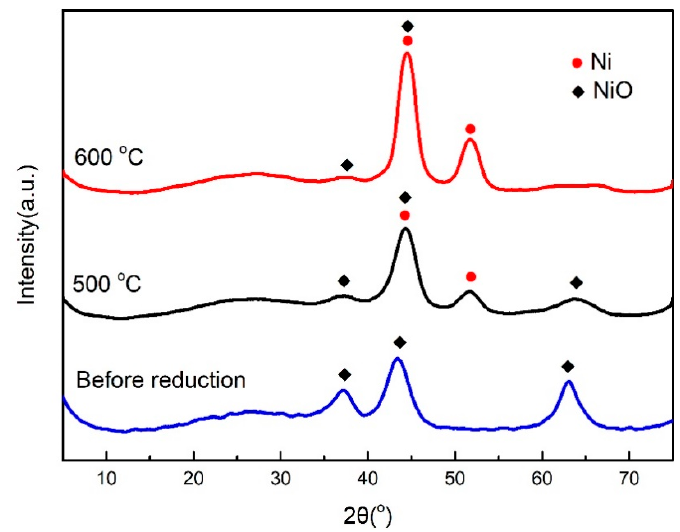
Figure 9. Powder XRD patterns of AMO-Ni 3 Al 1 -CO 3 -LDO reduced in hydrogen at different temperatures, ca. 500 and 600 °C.